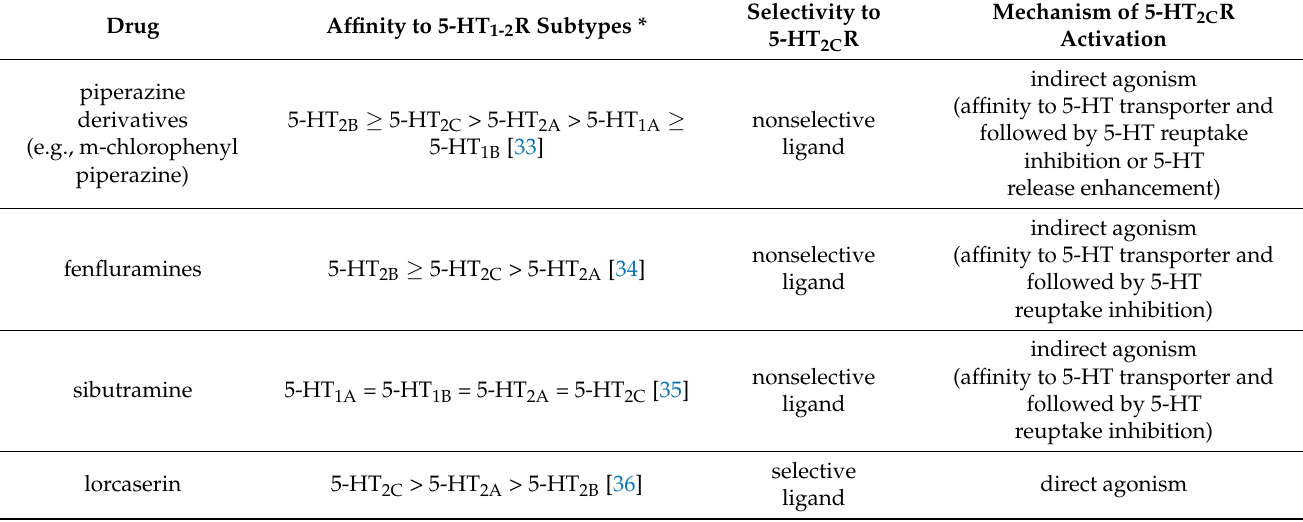
Table 1. Description of antiobesity drugs affinity to 5-HT 1-2 receptor (5-HT 1-2 R) subtypes, type of binding and mechanisms of 5-HT 2C receptor (5-HT 2C R)